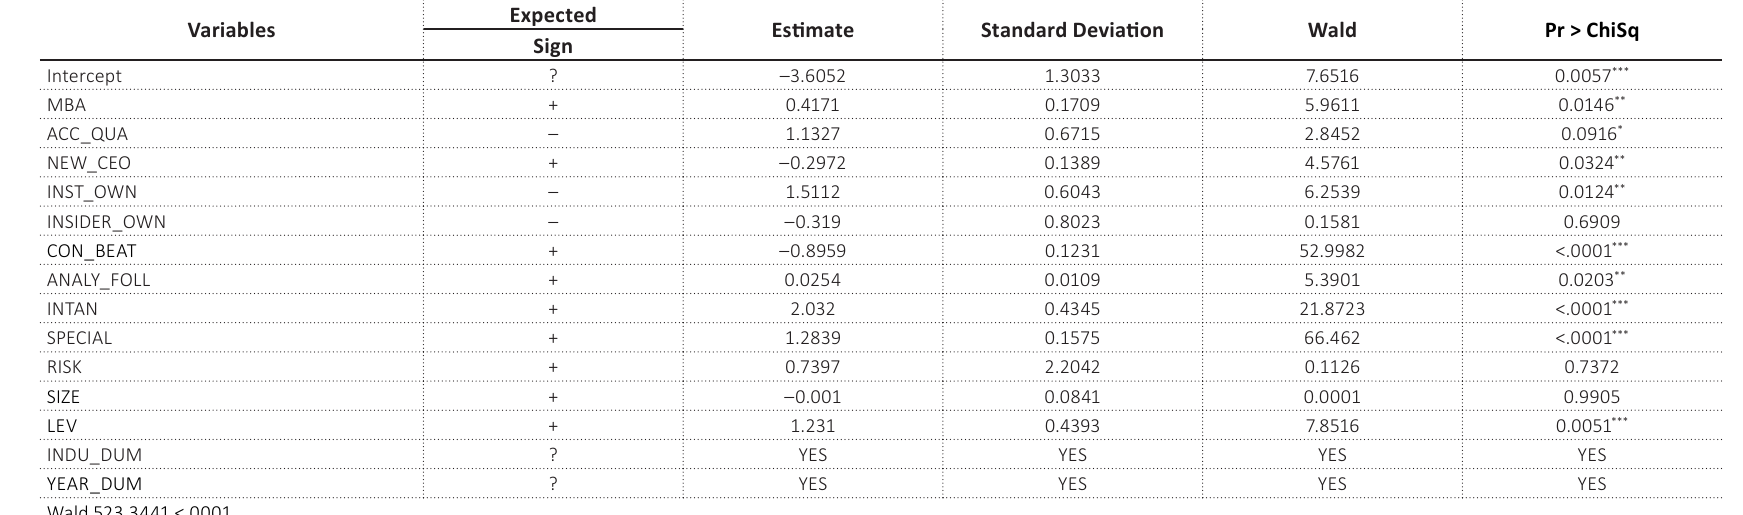
Table 5. The relationship between MBA-holding CEOs and non-GAAP earnings